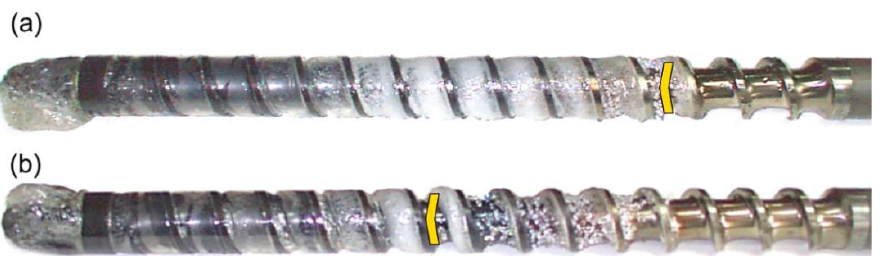
Figure 12. An effect of the plastication stroke on the polymer flow in the injection molding process at the screw speed N = 100 rpm, and the back pressure P back = 2 MPa: ( a ) h plast = 1 D, ( b ) h plast = 3 D.